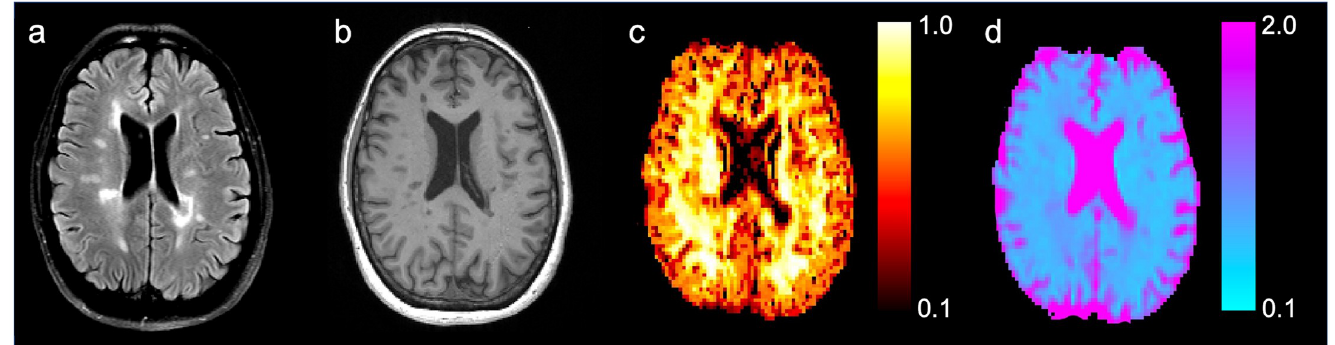
Fig 1. Example of an MR scan of an MS patient. Hyperintense FLAIR lesions displayed on FLAIR images (a) and unenhanced T1w images (b) with the corresponding colour-coded mean kurtosis (MK) (c) and mean diffusivity (MD) (in10 − 3 mm 2 /sec) (d) parameter maps.